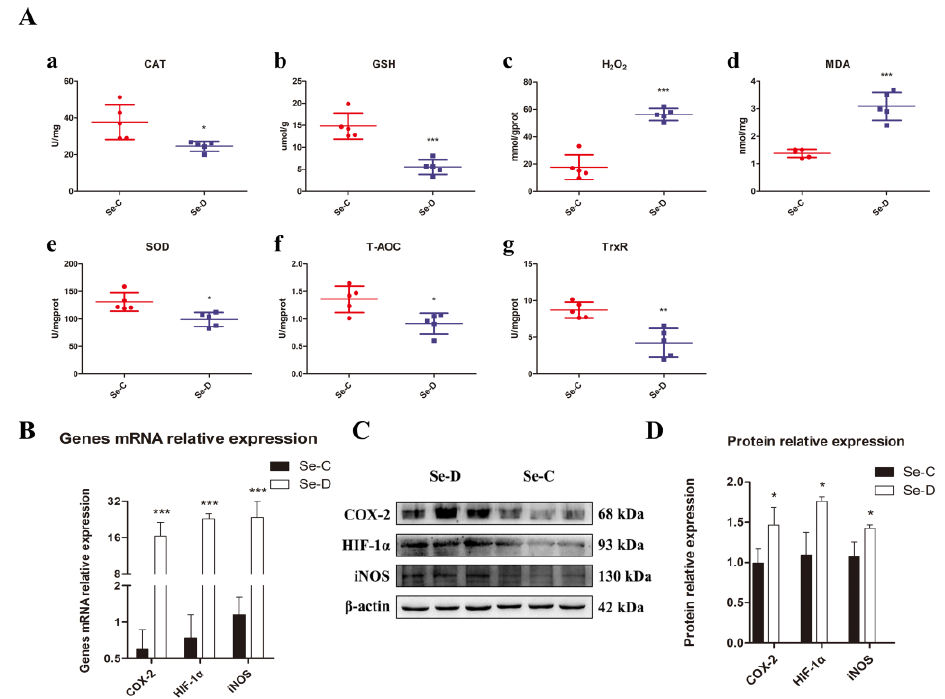
Figure 3. The antioxidant capacity of the lungs is assessed by the assay of ( A ) CAT activity (a), GSH concentration (b), H 2 O 2 concentration (c), MDA concentration (d), SOD activity (e), T-AOC (f), and TrxR activity (g). Gene expression and protein levels of oxidative stress-related protein COX-2 , HIF-1 α , and iNOS , are examined by RT-qPCR ( B ) and WB ( C , D ). The mean ± SD is used to present the data above, n = 5 calves per group (except for WB n = 3). * p < 0.05, ** p < 0.01, *** p < 0.001.